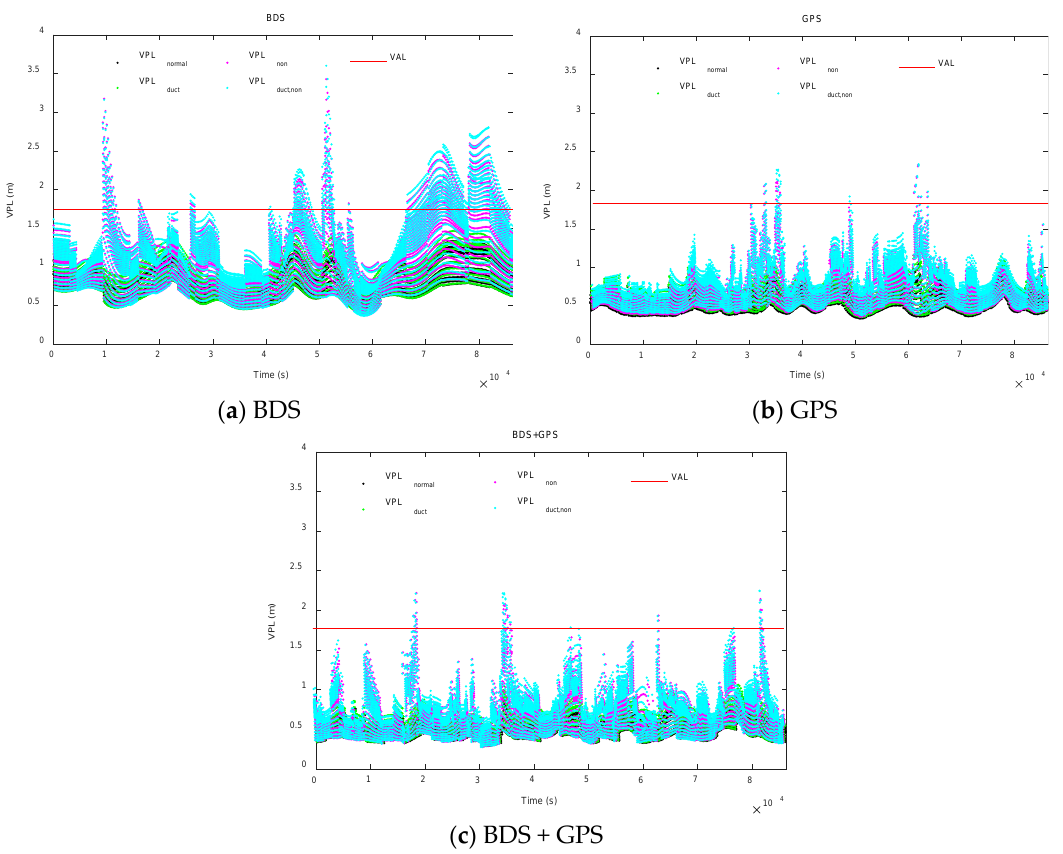
Figure 15. Vertical Protection Level (VPL) simulation results under BDS/Global Positioning System (GPS)/BDS + GPS constellations.